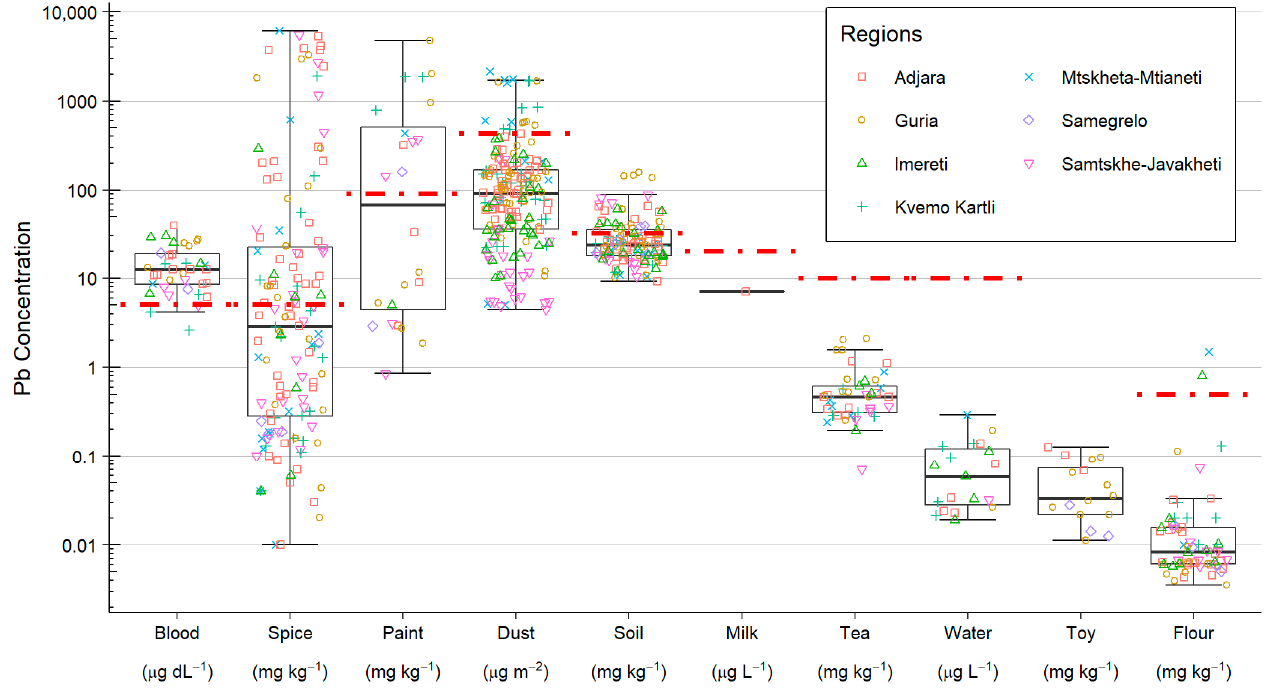
Figure 3. Box and whisker plot of the Pb concentrations for all samples. Where applicable, Georgian reference values are indicated by a horizontal red-dashed line.